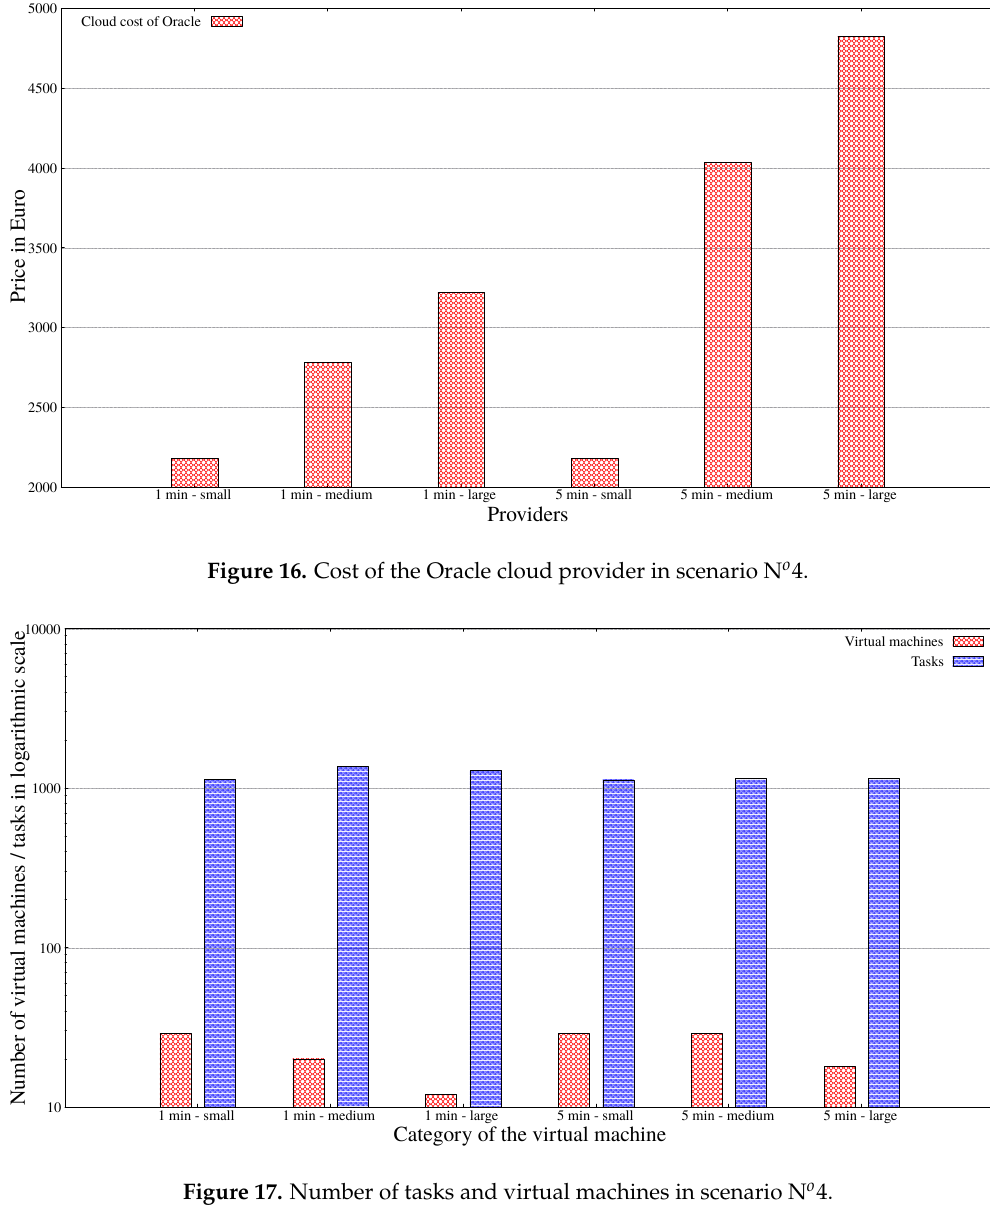
Figure 17. Number of tasks and virtual machines in scenario N o